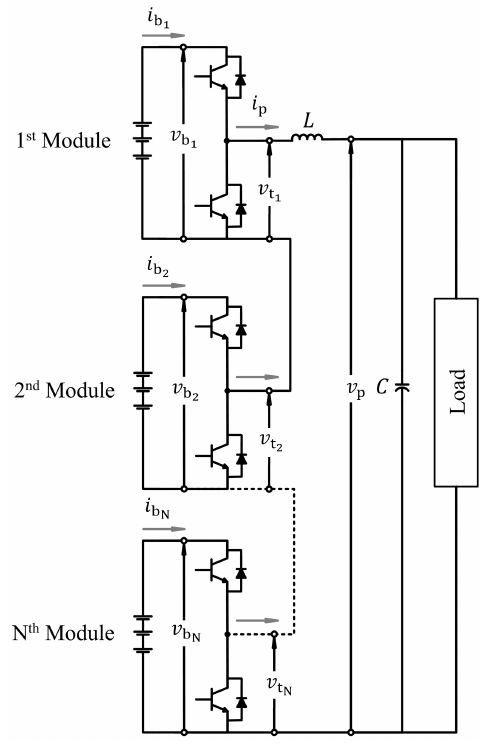
Figure 1. The modular reconfigurable